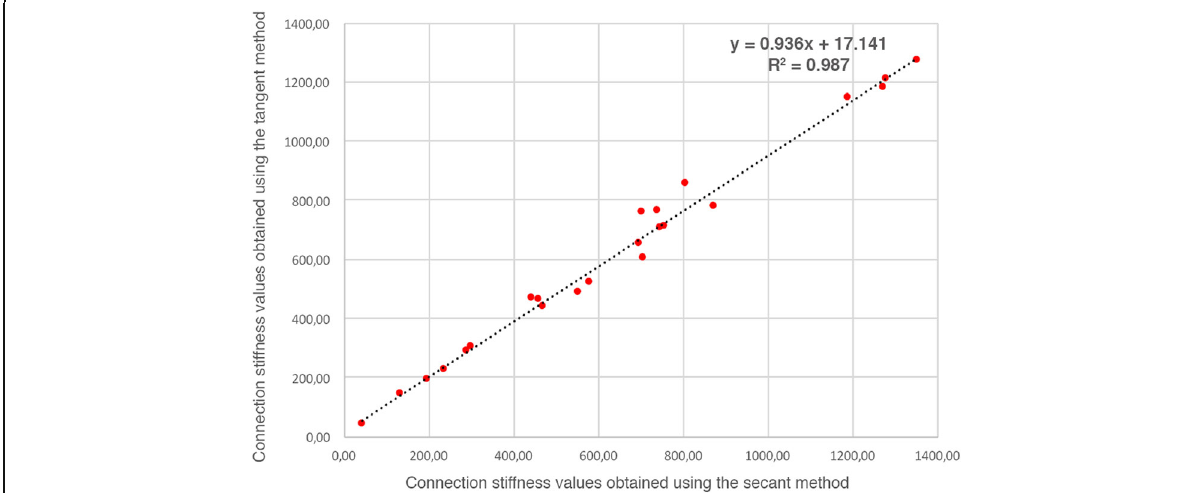
Fig. 4 Comparison among secant and tangent methods to calculate the connection stiffness values, which reveals the absence of mathematical